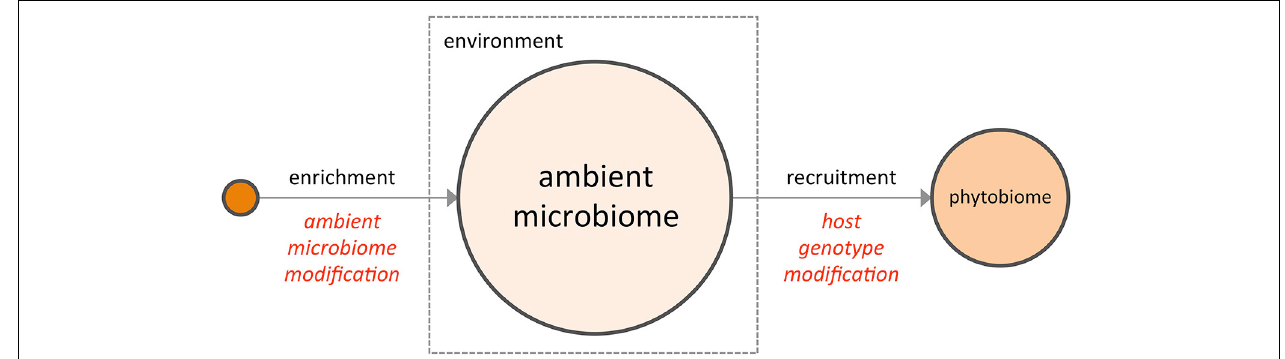
FIGURE 1 | The two complementary strategies for enhancing a crop phytobiome are direct modification of the ambient microbiome (e.g., the BSM, via inoculants or soil transfers) and the development of host genotypes better able to recruit a superior microbial assembly from the ambient